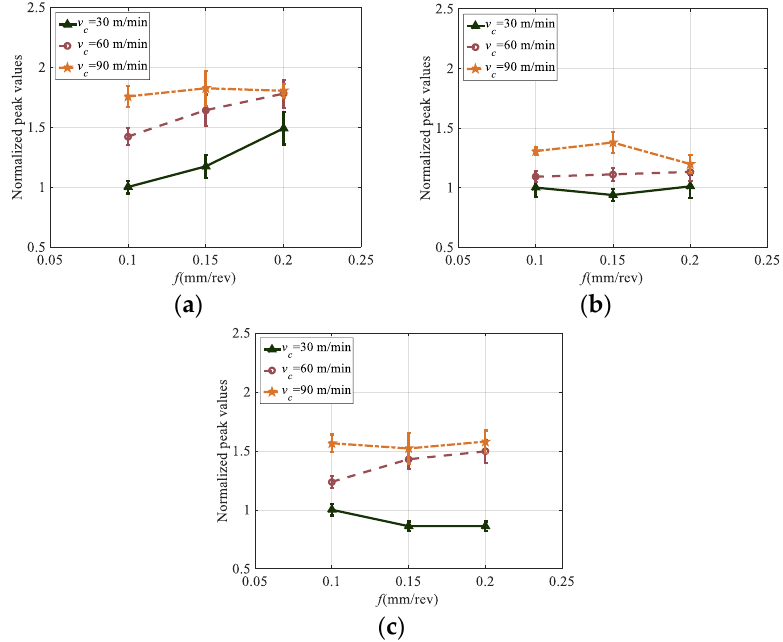
Figure 8. The influence of feed rate on milling forces: ( a ) Case 1 (milling in XY plane), ( b ) Case 2 (milling in XZ plane), ( c ) Case 3 (milling in YZ plane) for the workpiece built with the SSR of 90°.